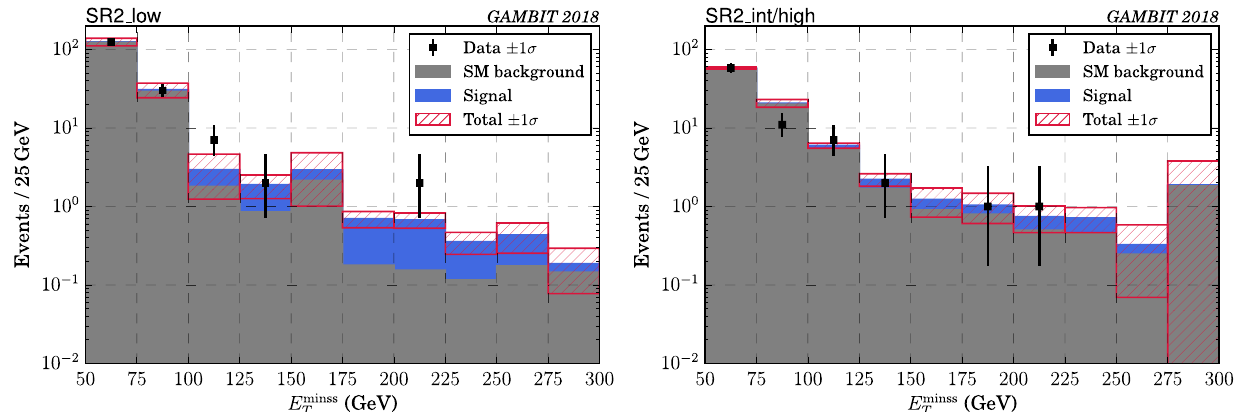
Fig. 20 Distribution of missing transverse energy in the 2 lepton plus jetssignalregionsofthetraditionaltraditionalATLASmultileptonanal- ysis, after applying all selection requirements. The grey bars show the total SM background (taken from Ref. [116]) and the stacked blue bars show the signal for our best-fit point based on the combination of 8